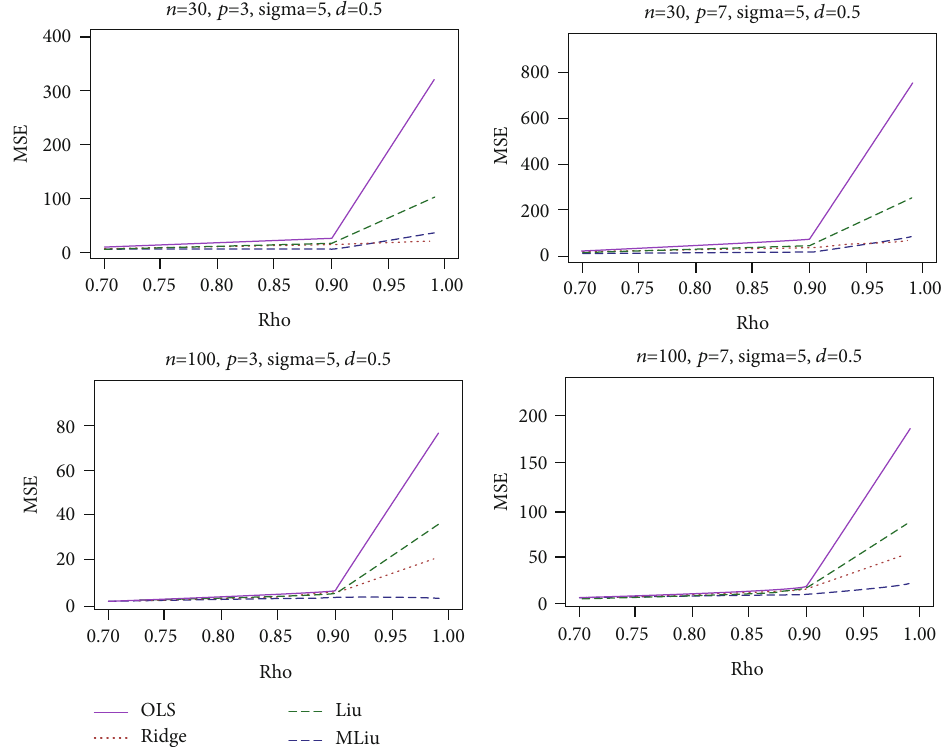
Figure 3: Estimated MSEs for sigma = 5 , p = 3 , d = 0 : 5 , and di ff erent values of ρ and n